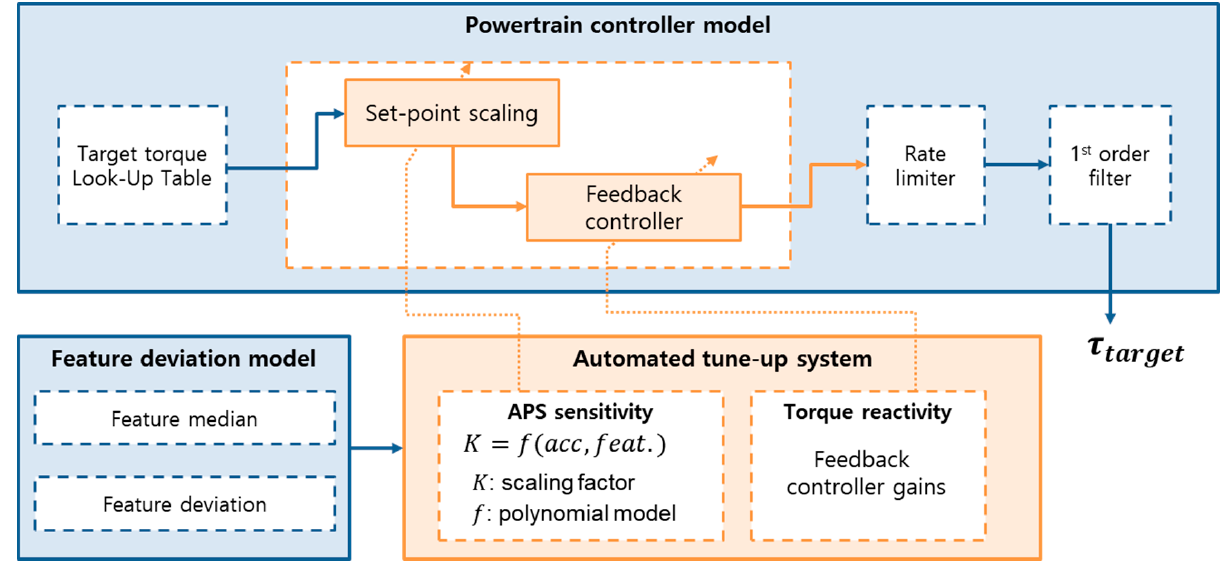
Figure 10. Target torque adjustment according to the feature deviation model.